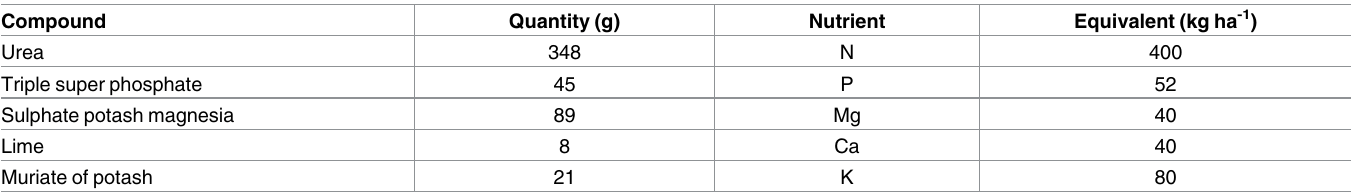
Table 1. Fertilizer component compounds and quantity applied to each plot in November 2011. Also given are the nutrient contributed by each com- pound and the per unit area nutrientequivalent.